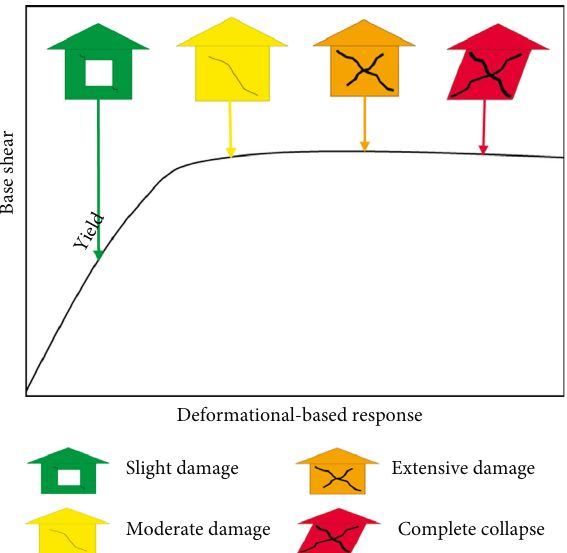
Figure 2: HAZUS-based illustration of different structural damage states, depending upon the structural deformation-based